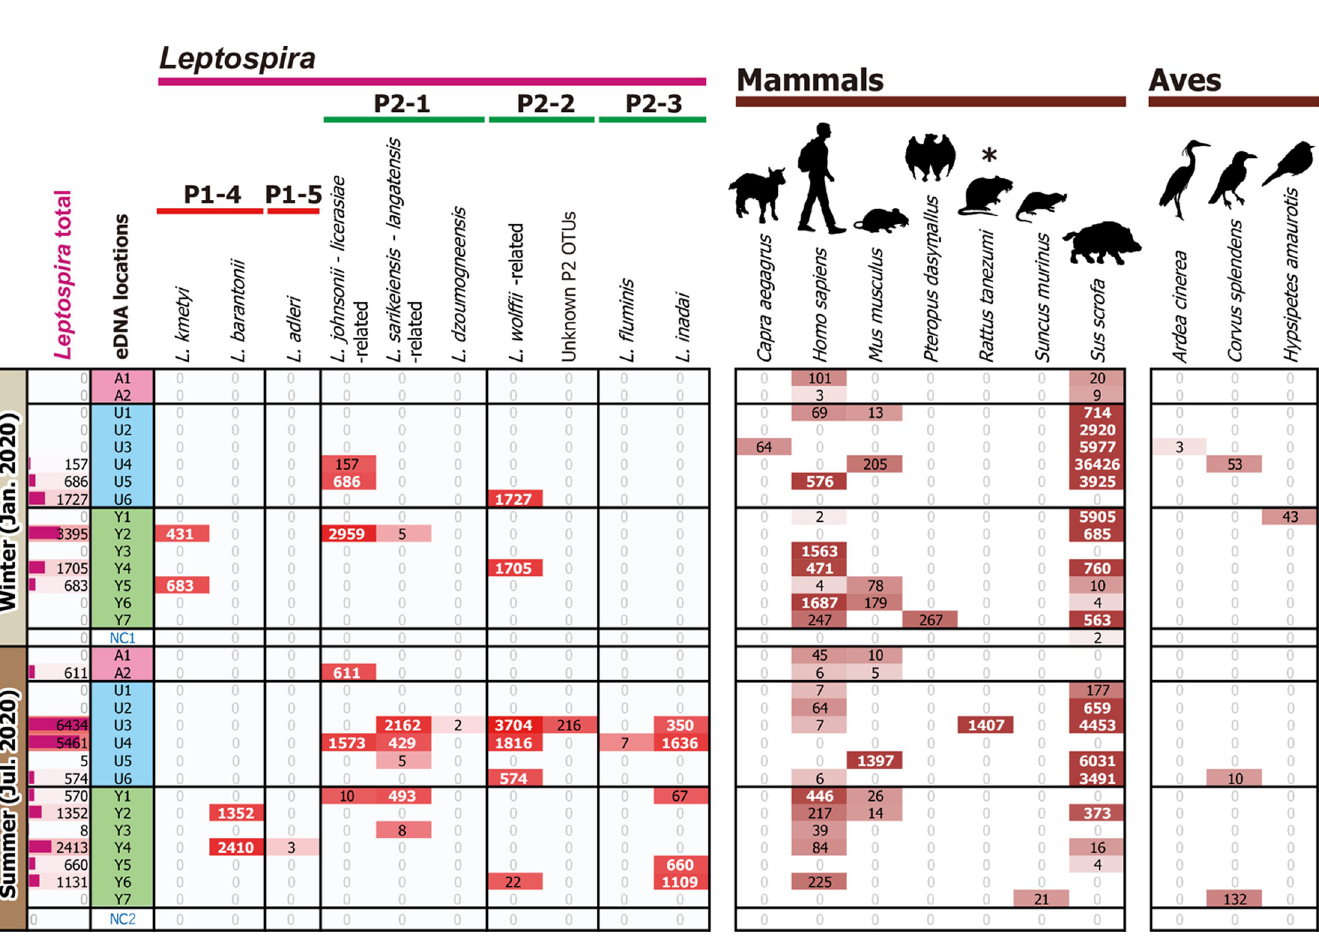
Fig 5. Environmental detection of leptospiral 16S rRNA gene and tetrapod mitochondrial 12S rRNA gene. Columns denote the species of Leptospira and tetrapods species, and rows denote the number of sequence reads detected in each sample. The reads are shown with colored matrices in red and brown shading for Leptospira and tetrapods, respectively, where the color intensity is relative to the read numbers. More than 300 reads are indicated by white bold white letters. P1-4 and -5, and P2-1 to -3 denote the phylogenetic subclades of Leptospira species based on Guglielmini et al . (2019) [1]. The leftmost “ Leptospira total” column indicates the summed read numbers across all Leptospira species. Asterisks indicate tetrapod species that exhibited a significant correlation with detection of either species of Leptospira (Pearson’s product-moment correlation coefficient r > 0.361, d . f . = 28, two-tailed p < 0.05, and Benjamini–Hochberg-corrected false discovery rate q < 0.01). Y, U, and A indicate sampling locations Yutsun, Udara, and Ayanda Rivers, respectively. Y1 − Y7, U1 − U6, and A1 and A2 denote sample names. NC indicates negative control samples (RNase free water).